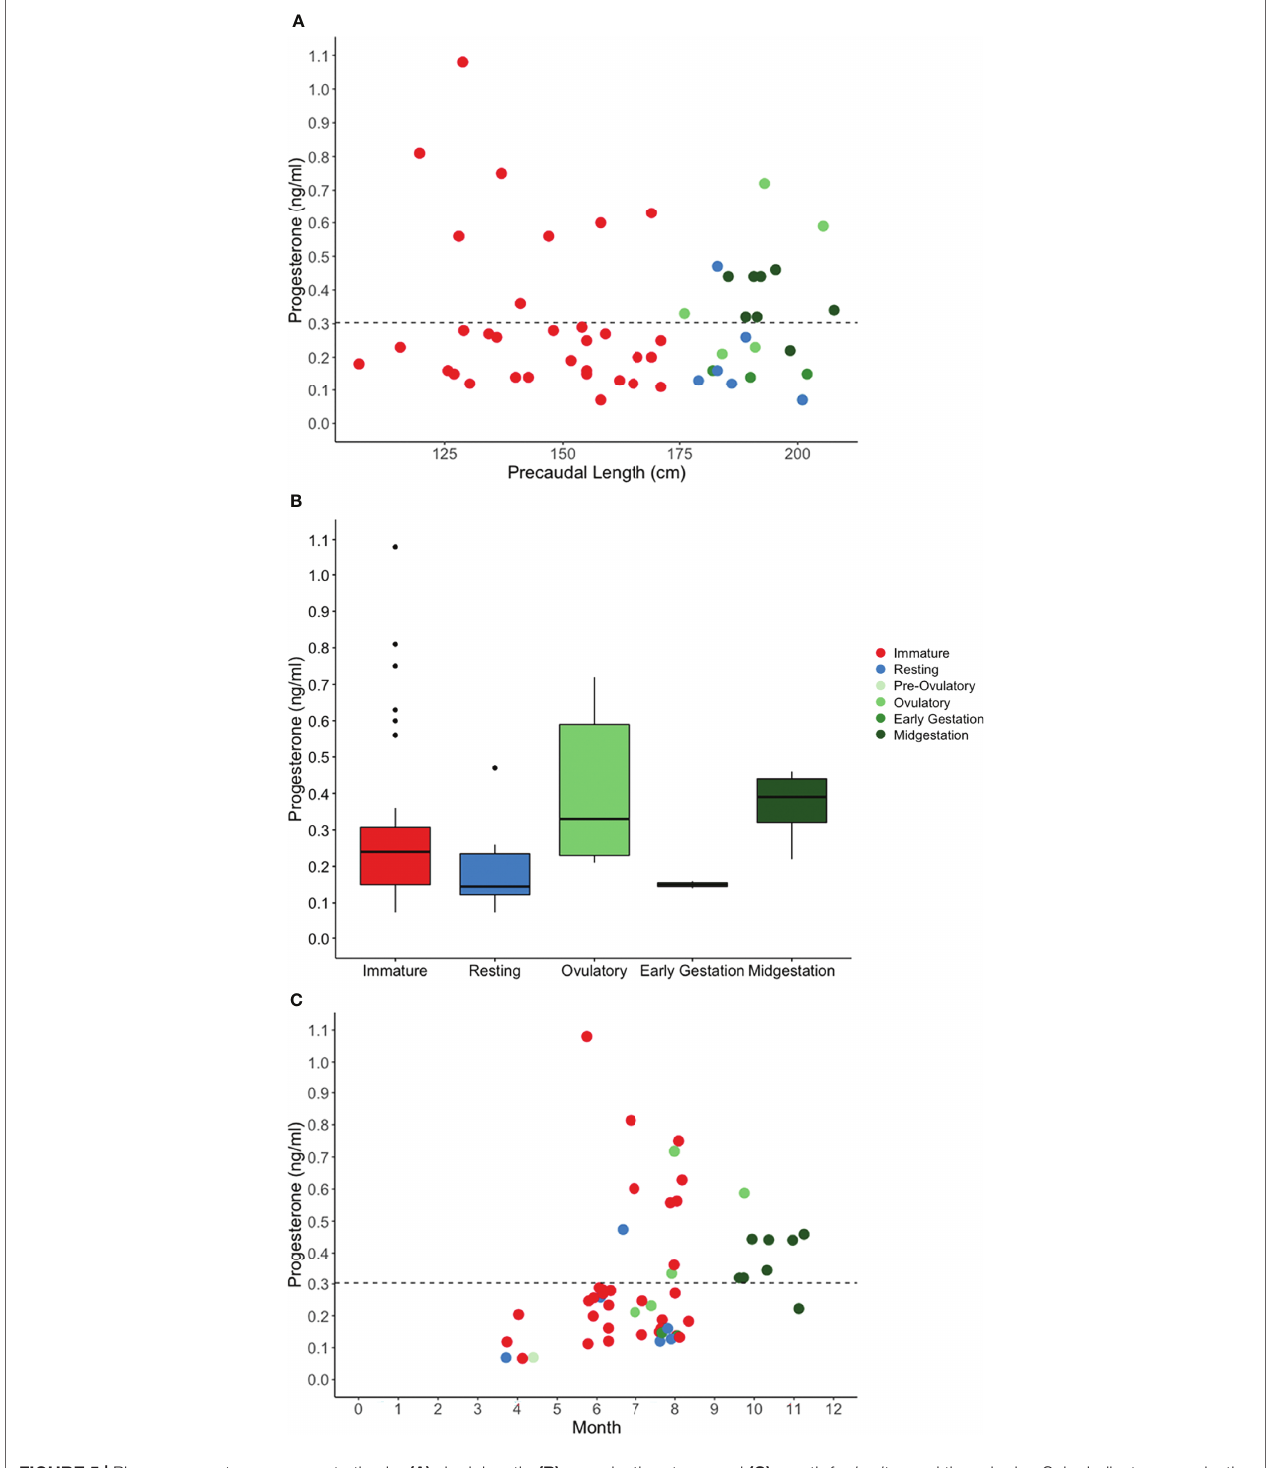
FIGURE 5 | Plasma progesterone concentration by (A) shark length, (B) reproductive stage, and (C) month for in situ sand tiger sharks. Color indicates reproductive stage and the dotted line represents the threshold for elevated hormone